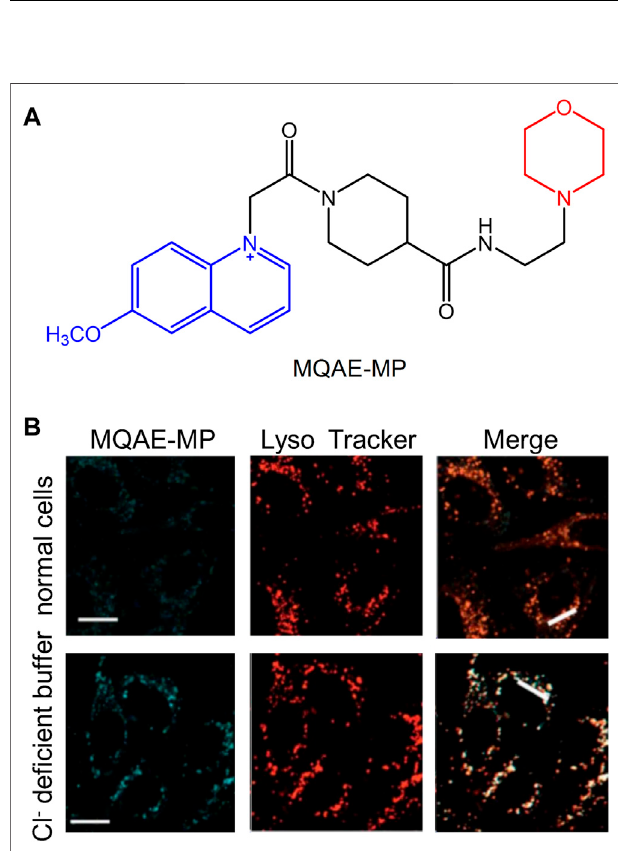
FIGURE 12 | The structure and fl uorescence characteristic of MQAE- MP (Sang-Hyun et al., 2019). (A) The chemical structure of MQAE-MP . (B) The detection of Cl − ions in cells with MQAE-MP